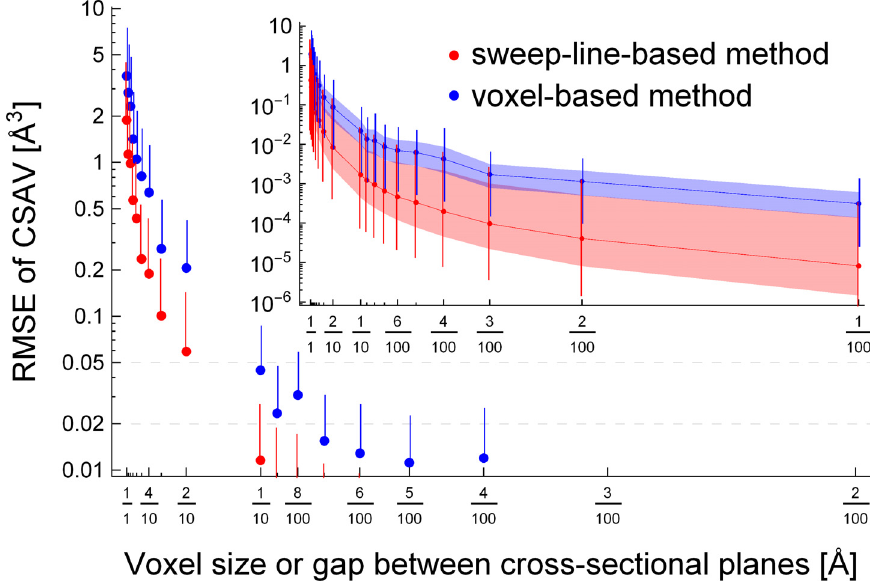
Fig 10. The comparison of the error distributions determined using the sweep-line-based method (red) and the voxel-based method (blue) by determining CSAVs of random systems in various gaps between cross-sectional planes or the voxel